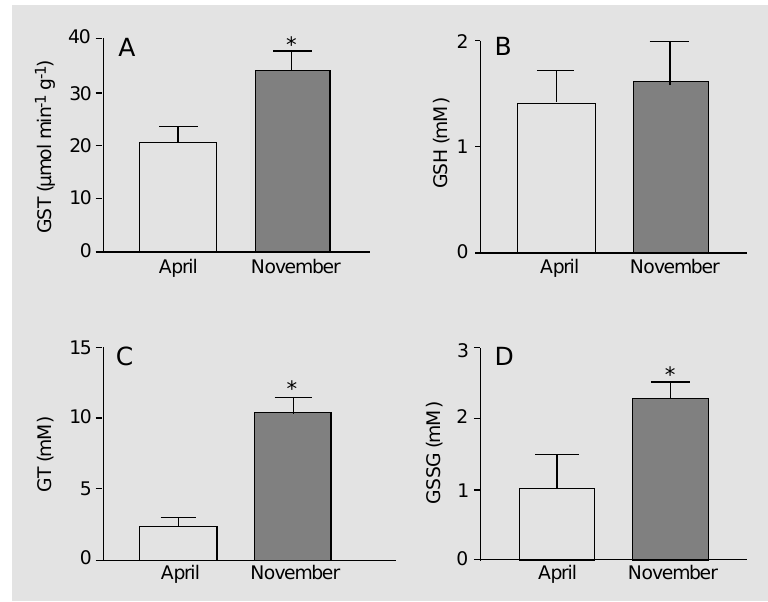
Figure 5. Seasonal pattern of different parameters measured in the liver of Geophagus brasiliensis. A , Glutathione S-transferase activities (GST, µmol min -1 g -1 ); B , reduced gluta- thione (GSH, mM); C , total glutathione (GT, mM); D , oxidized glutathione (GSSG, mM). *P<0.05 compared to samples collected in April (Student